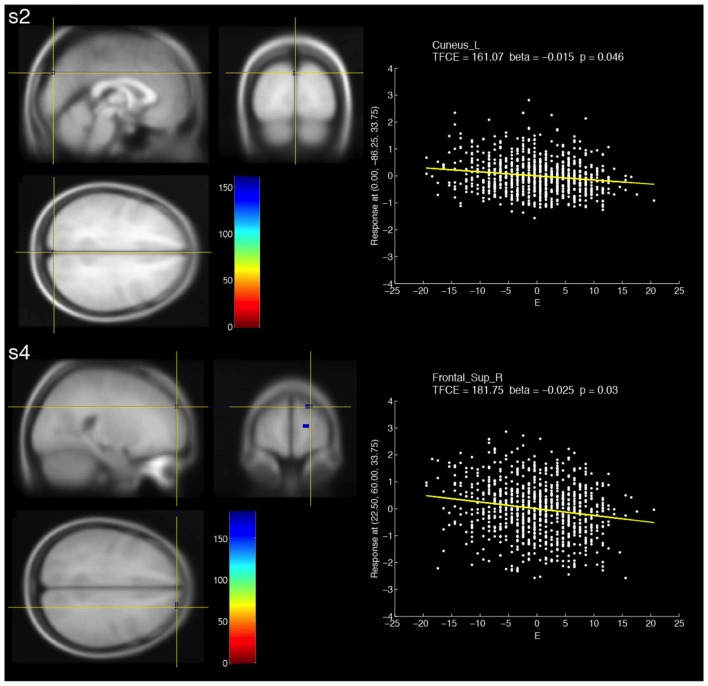
Brain areas that showed significant negative correlations with fALFF at two different frequency bands (s2: slow-2, s4: slow-4) and extraversion scores (E). The resulting TFCE maps were thresholded with a voxel-wise significance of a FWE-corrected p < 0.05 and overlaid on the avg305T1 template using SPM8. The color bar indicates the TFCE magnitude. The peak voxels for the two bands are marked by the yellow cross-hairs. Each scatter plot shows the relationship between the E score (minus the mean value) and fALFF at the peak voxel. The nuisance covariates were regressed out at the peak voxel. Each yellow line within the scatter plot shows the fALFF predicted from the E score.